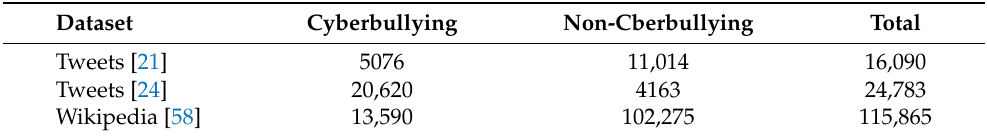
Table 2. The statistics of experiment